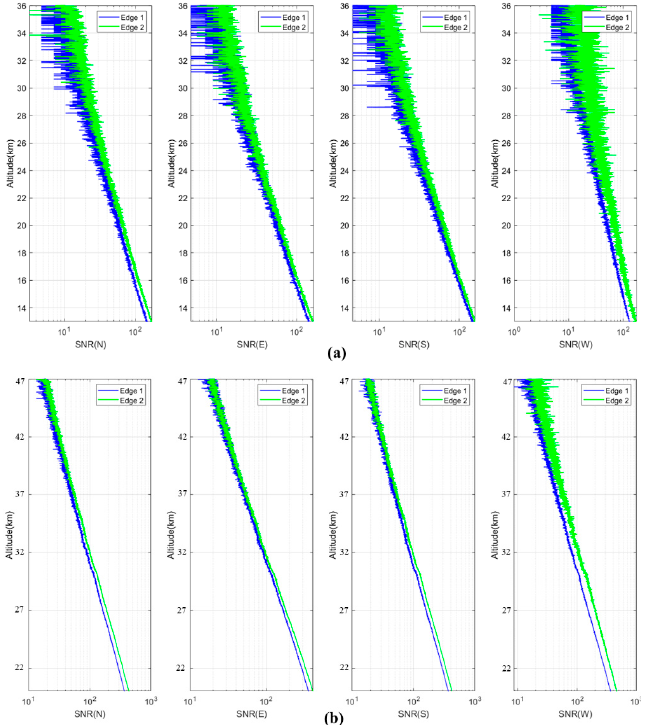
Figure 15. The SNR profiles in four detection directions. ( a ) Original ( b ) Upgraded.